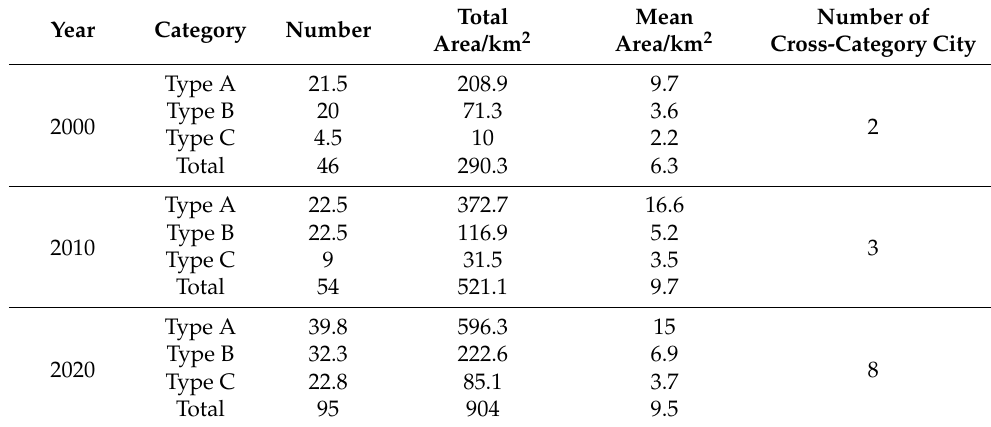
Table 4. Statistical description of PUAs for settlements by different categories.